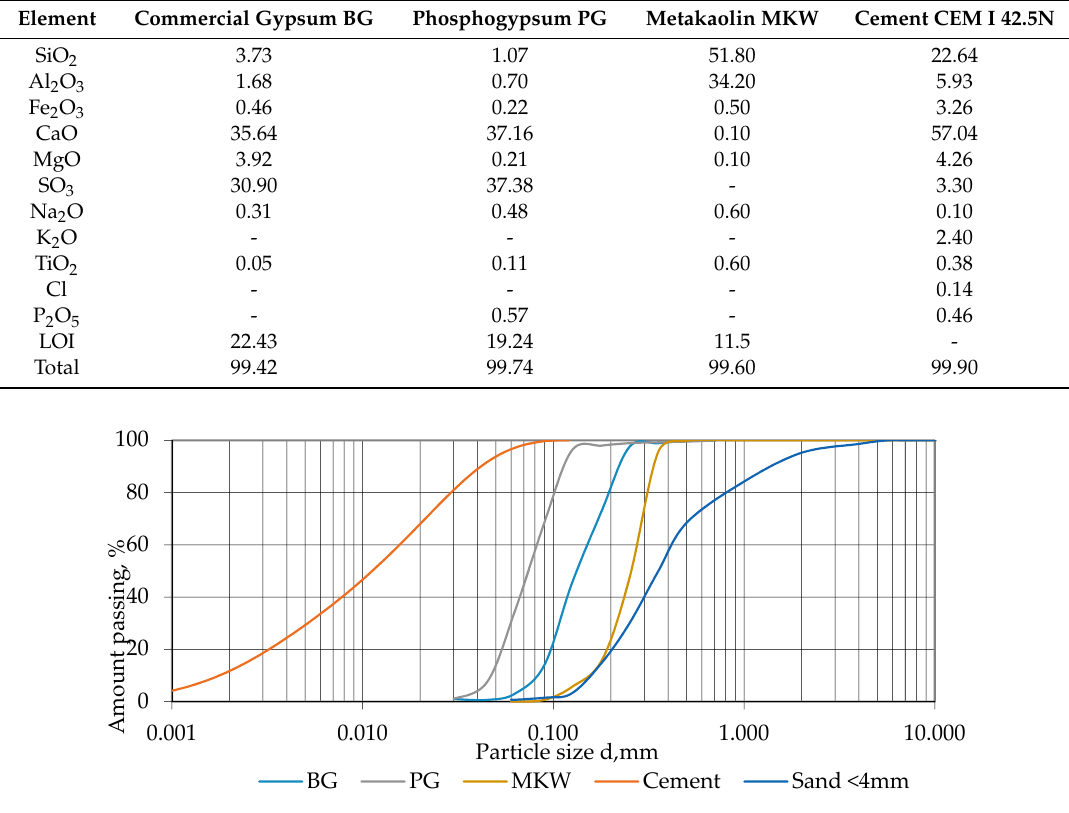
Table 1. Chemical composition of raw materials used to prepare novel building material [weight %].